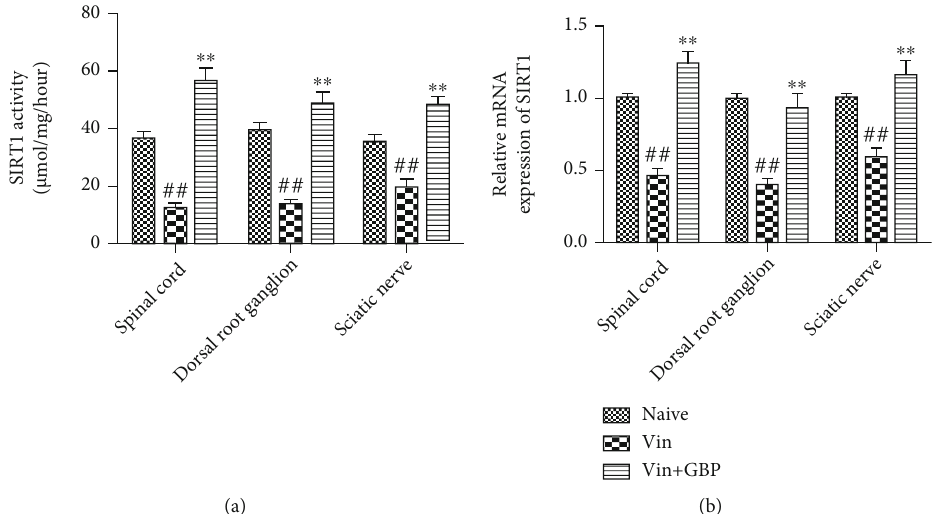
Figure 8: G. elata polysaccharides (GBP) alleviated Vin-induced neuropathic pain via activating the SIRT1 in rats. After completion of the pain behavioral tests on day 21, the sciatic nerve, spinal cord, and dorsal root ganglion (DRG) were collected. SIRT1 activity (a) and mRNA expression of SIRT1 (b) were measured. Data were expressed as the mean ± SD ( n = 6 for each group). # P < 0 : 01 : vs. naive group; ∗∗ P < 0 : 01 : vs. Vin group. One-way ANOVA followed by Bonferroni ’ s post hoc